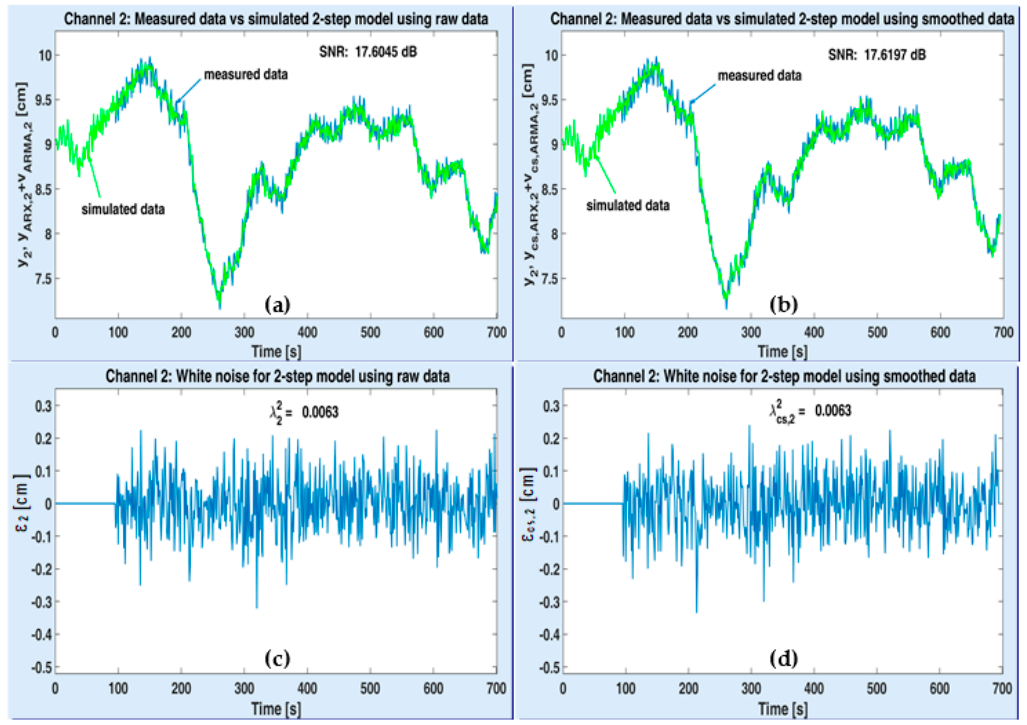
Figure 12. Performance of the optimal 2-step MISO model associated to ASTANK2 installation, on channel 2: measured versus simulated outputs with raw data ( a ) and smoothed data ( b ); estimated white noise from raw data ( c ) and smoothed data ( d ).